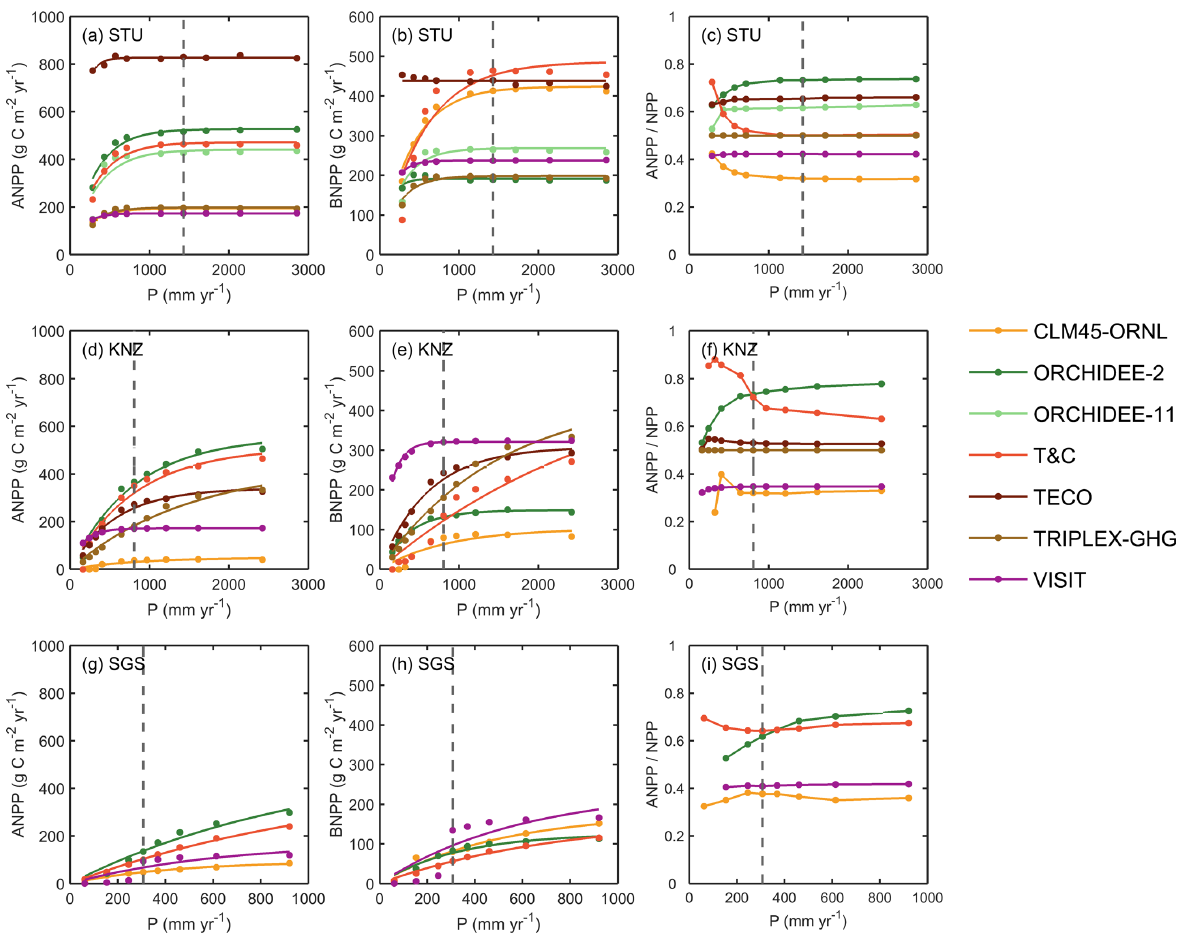
Figure 5. Responses of simulated annual ANPP (a, d, g) , BNPP (b, e, h) , and the ratio of ANPP and NPP (c, f, i) to altered and ambient precipitation ( P ) levels at the three sites STU, KNZ and SGS. The fitted equation is Eq. (8) for ANPP and BNPP (see Fig. S4 for fitted a and b ). The grey dashed line represents ambient precipitation. It should be noted that the x -axis scales are different between the